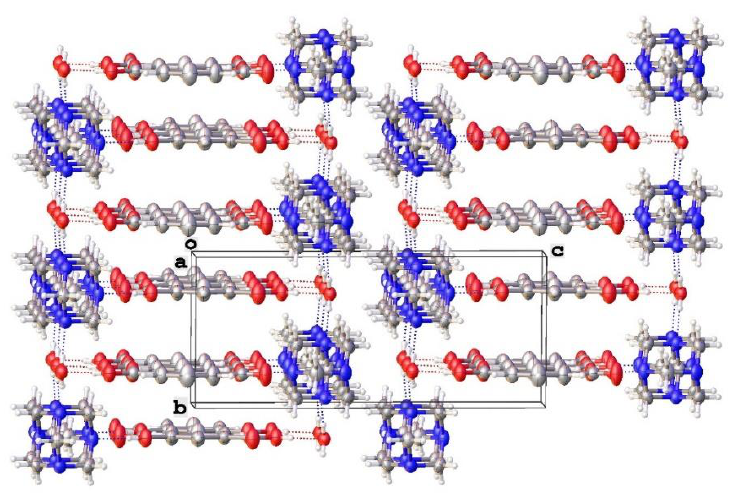
Figure 2 . Molecular packing of compound 1 .